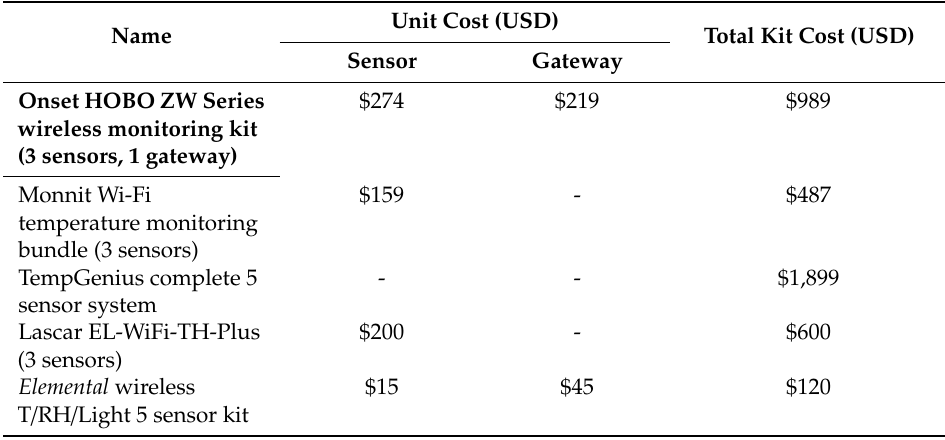
Table 3. Comparative unit and total cost of deployment of existing commercially available wireless solutions versus the Elemental wireless sensor